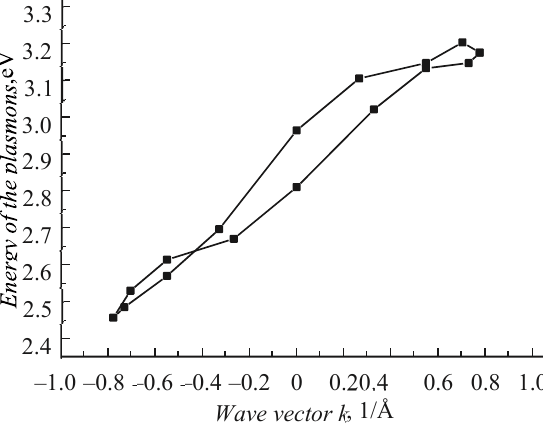
Figure 7. Dispersion of surface plasmons for a single crystal LiF [34]. Processing of this narrow loop of plasmon dispersion for lithium fluoride using the empirical Equation (25) resulted in an abnormally low value of its average plasmon energy, which is almost two orders of magnitude less than the average energy of plasmons in fused quartz and is only: E P = 0.0072 eV However, the calculation of the average electron asymmetry in a lithium fluoride crys- tal taking into account the characteristics of lithium and fluorine atoms [21,23] according to a scheme similar to the calculation of fused quartz showed the value for LiF asym = 1.74 which practically coincides with the corresponding characteristic of fused quartz. The large value of the average electron asymmetry of lithium fluoride is explained by the mechanism of dielectric polarization associated with the large dipole moment in the debs (D) of